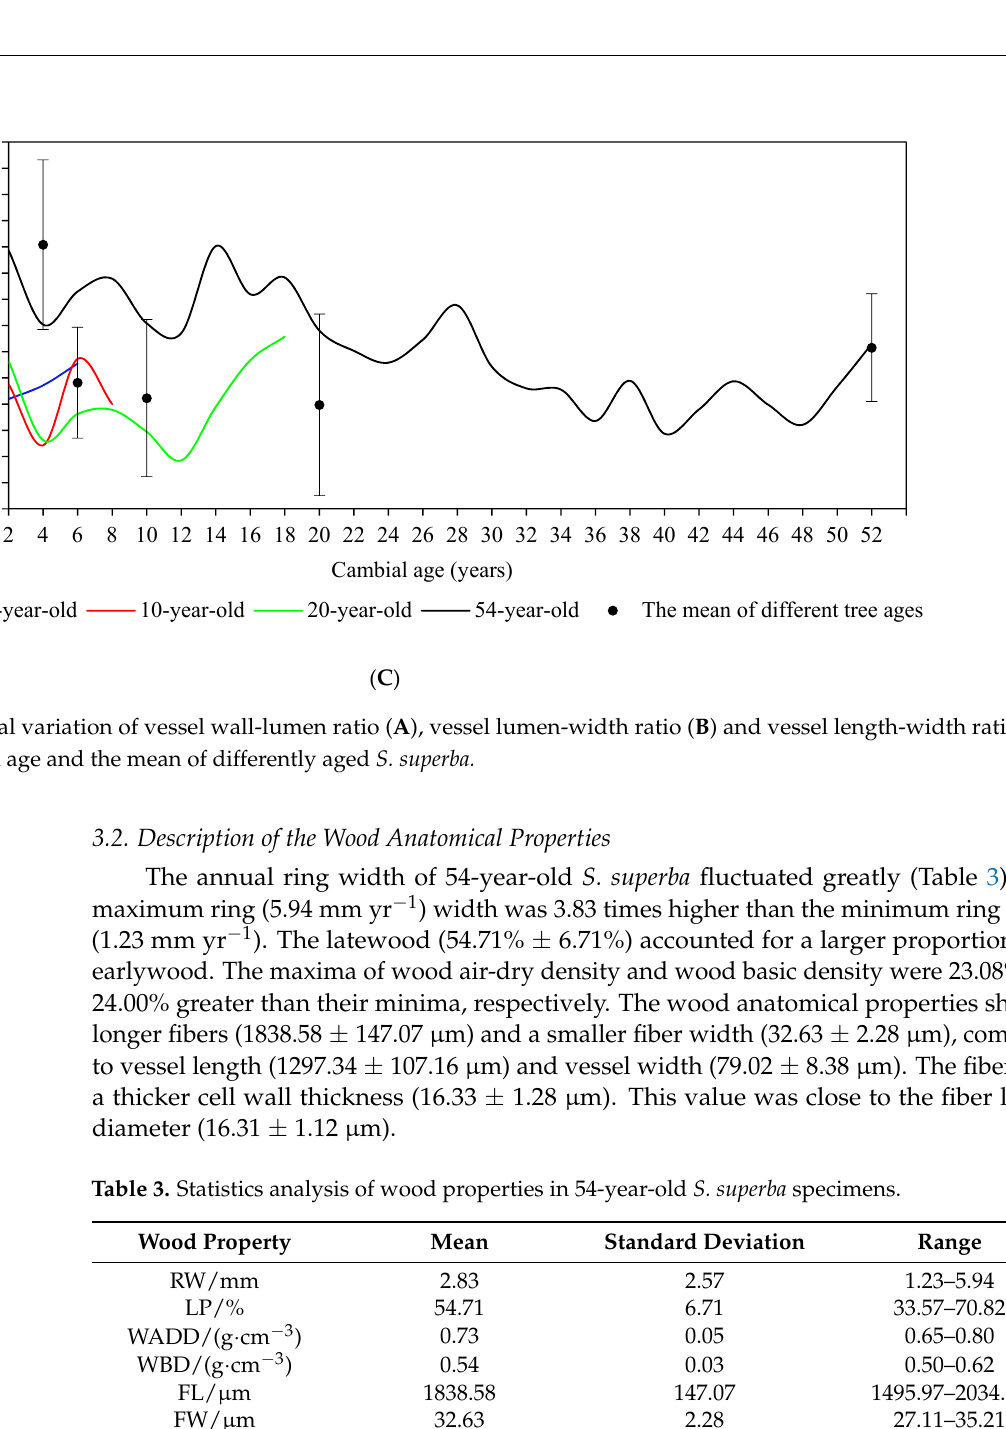
Figure 9. The variation coefficient of wood properties of S. superba in the first 20 years, 20 years later and in all years. RW: ring width, LP: latewood percentage, WADD: wood air-dry density, WBD: wood basic density, FL: fiber length, FW: fiber width, FLD: fiber lumen diameter, FCWT: fiber cell wall thickness, VL: vessel length, VW: vessel width, VLD: vessel lumen diameter, VCWT: vessel cell wall thickness.